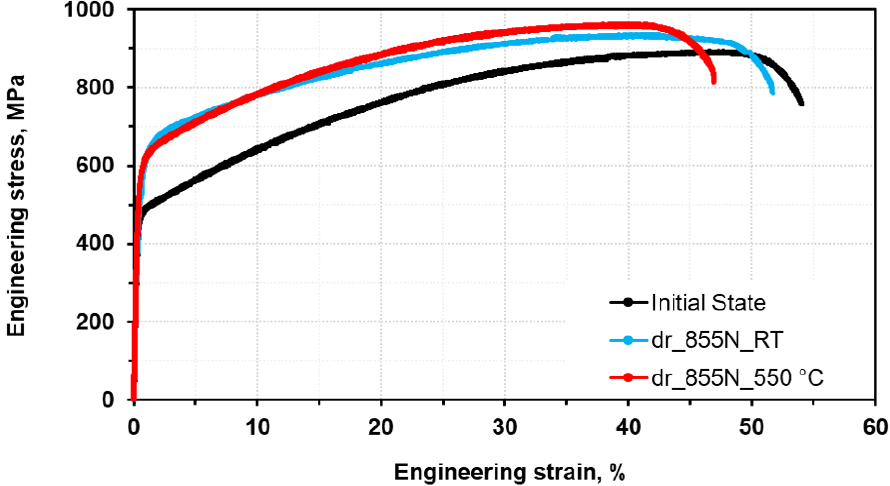
Figure 4. Monotonic stress–strain response of the specimen deep rolled at 550 °C applying a deep rolling force of 855 N. Data of the initial state condition and of the condition deep rolled at RT using a deep rolling force of 855 N were recompiled from [39].